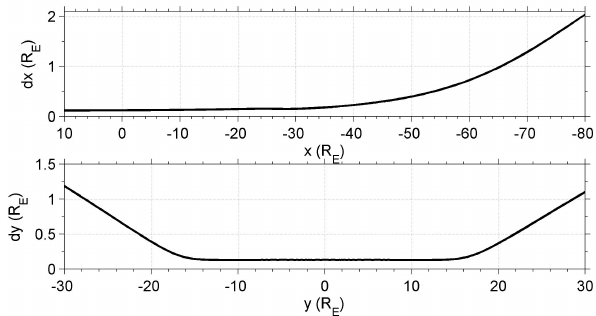
Fig. 1. Distribution of the grid spacing in the MHD simulation. The top panel shows the grid spacing in the x-direction versus x , the bottom panel shows the grid spacing in the y-direction. The grid spacing in the z-direction is the same in this